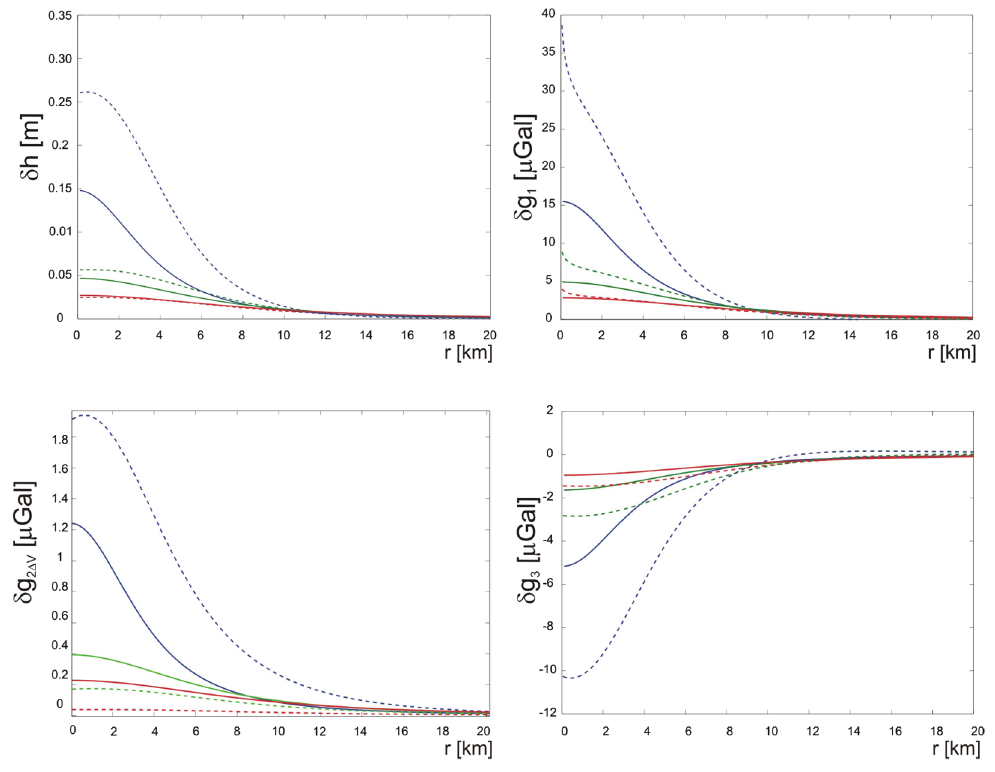
Fig. 5. Numerical (dashed lines) and homogeneous half-space solutions (solid lines) for the elevation changes and the δ g 1 , δ g 2 ∆ V and δ g 3 gravity contributions, including the topography effect. The increase in the gravity field depends on the depth of the source: 3 km (blue), 6.5 km (green), 9 km